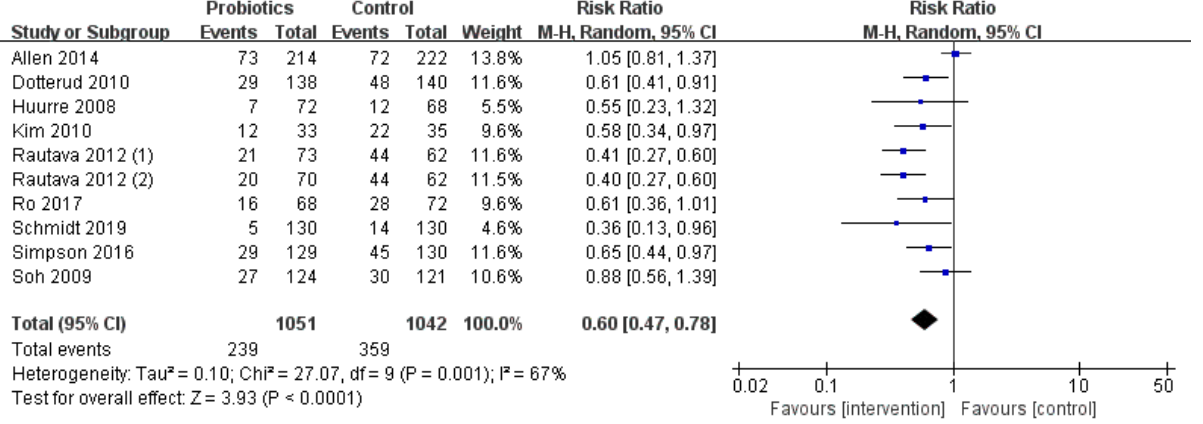
Figure 4. Forest plot of the relationship between Lactobacillus and Bifidobacterium and infant eczema.